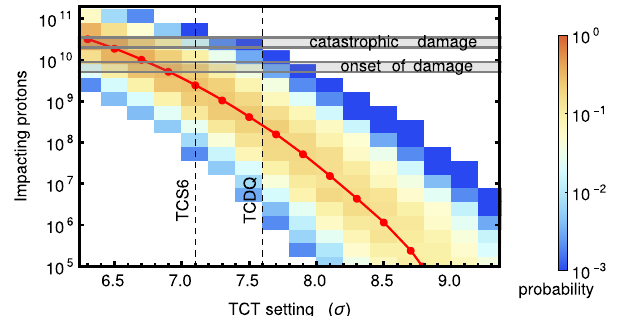
FIG. 8. The simulated losses during a single-module prefire from PSI on the TCT in IR1, B1, when all IR7 collimators are retracted, as a function of TCT setting. The solid red curve shows the result for a perfect optics, while the color scale shows, for each TCT setting, the probability distribution of losses under the influence of random phase errors compatible with the LHC optics correction. The results are shown together with the TCT damage limits given in Ref.